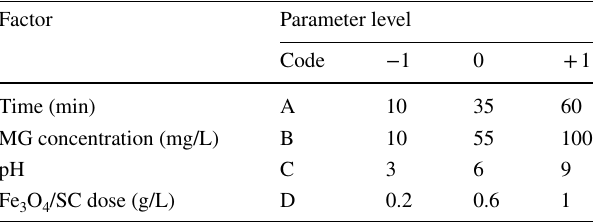
Fig. 2 FTIR spectra of (A) before and (B) after MG